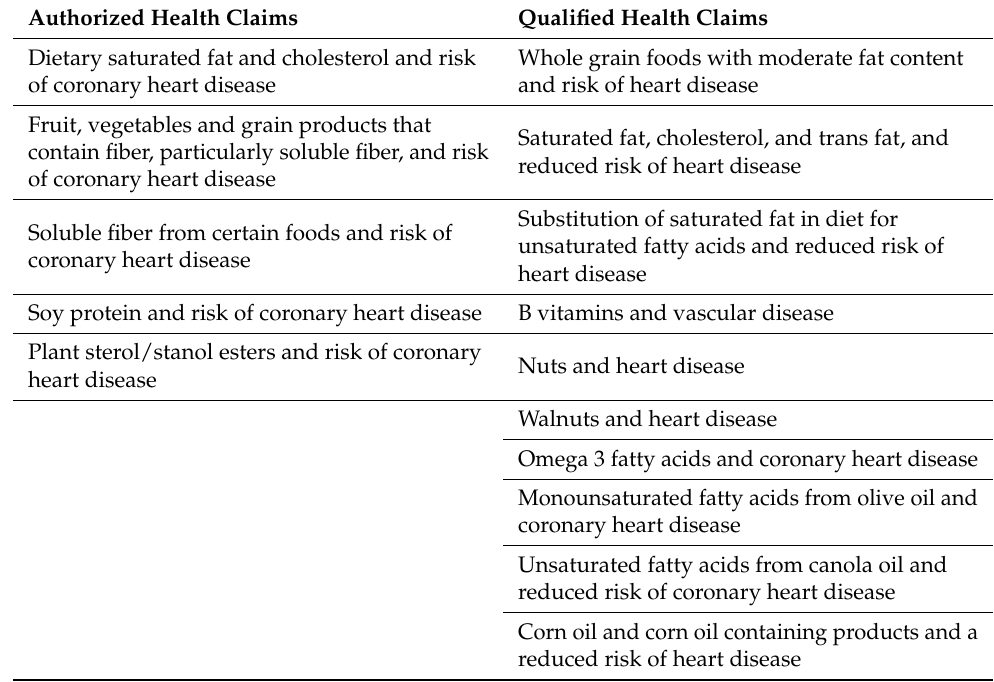
Table 1. List of authorized claims in the USA with direct or indirect impact on microcirculation.